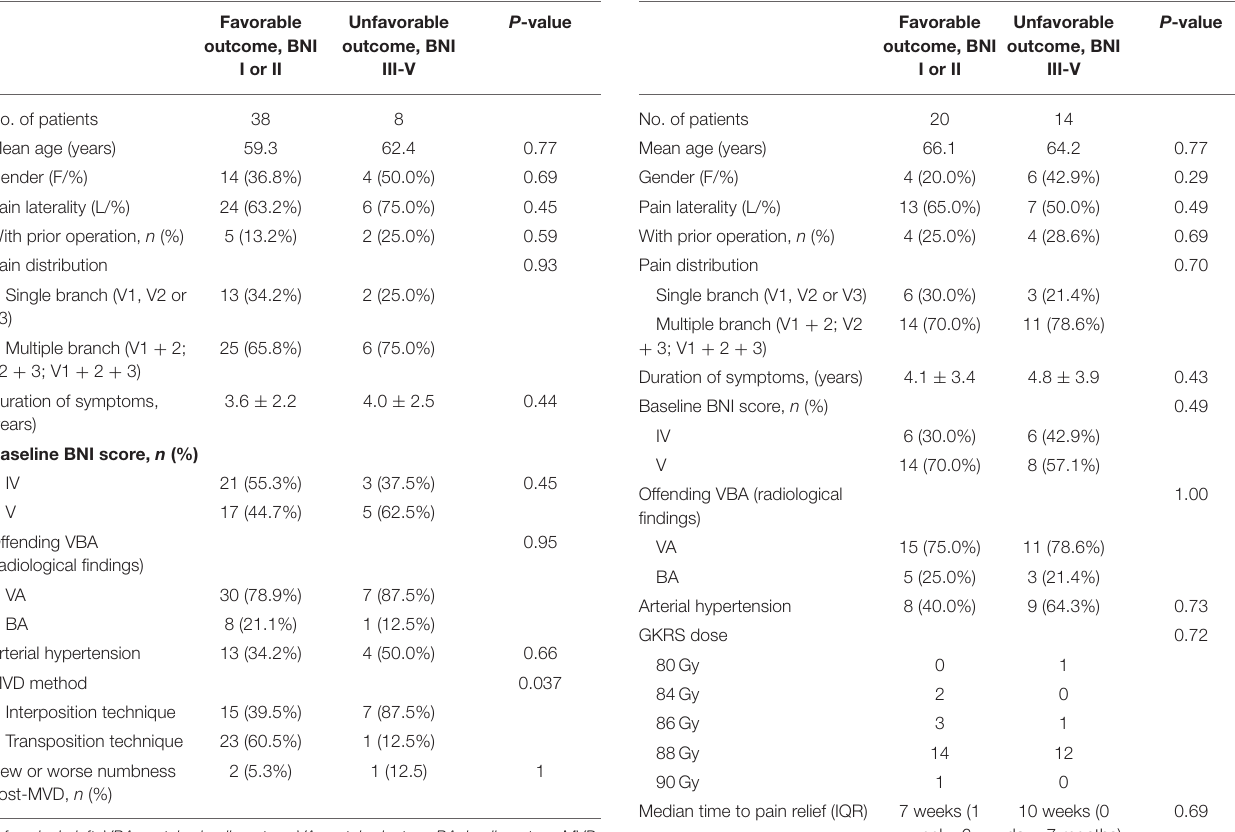
TABLE 4 | Comparison of clinical factors between favorable outcomes and unfavorable outcomes in GKRS group.